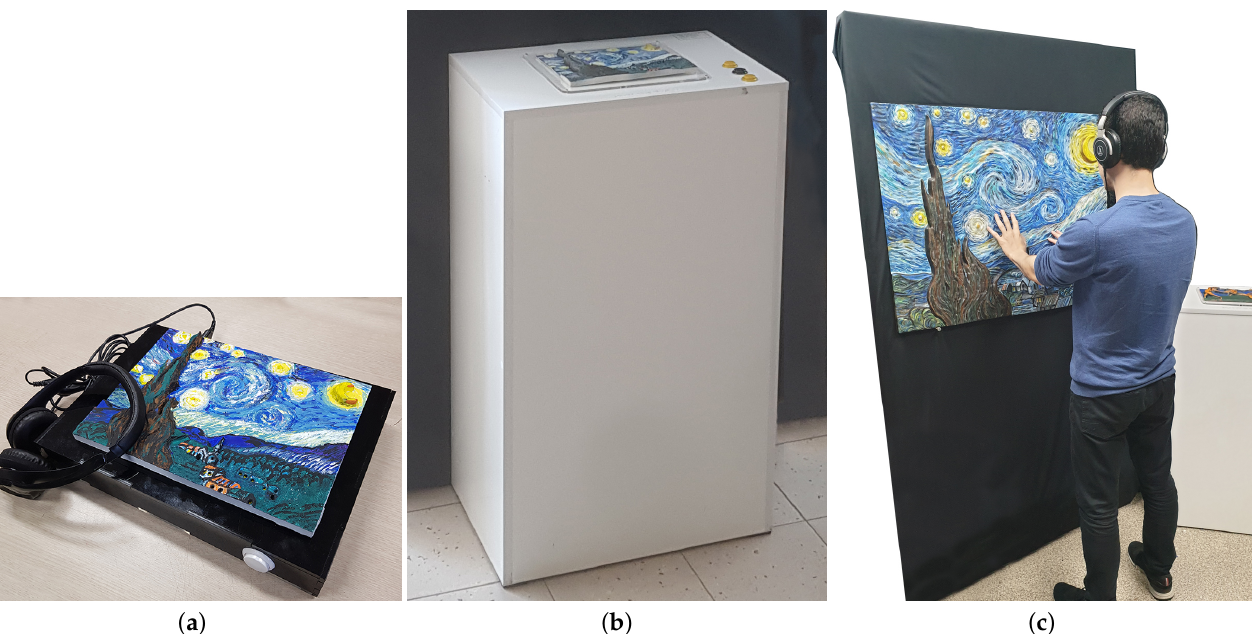
Figure 2. Interactive Multimodal Guide prototypes. ( a ) Portable IMG prototype; ( b ) Standing exhibition IMG; ( c ) Verti- cal exhibition